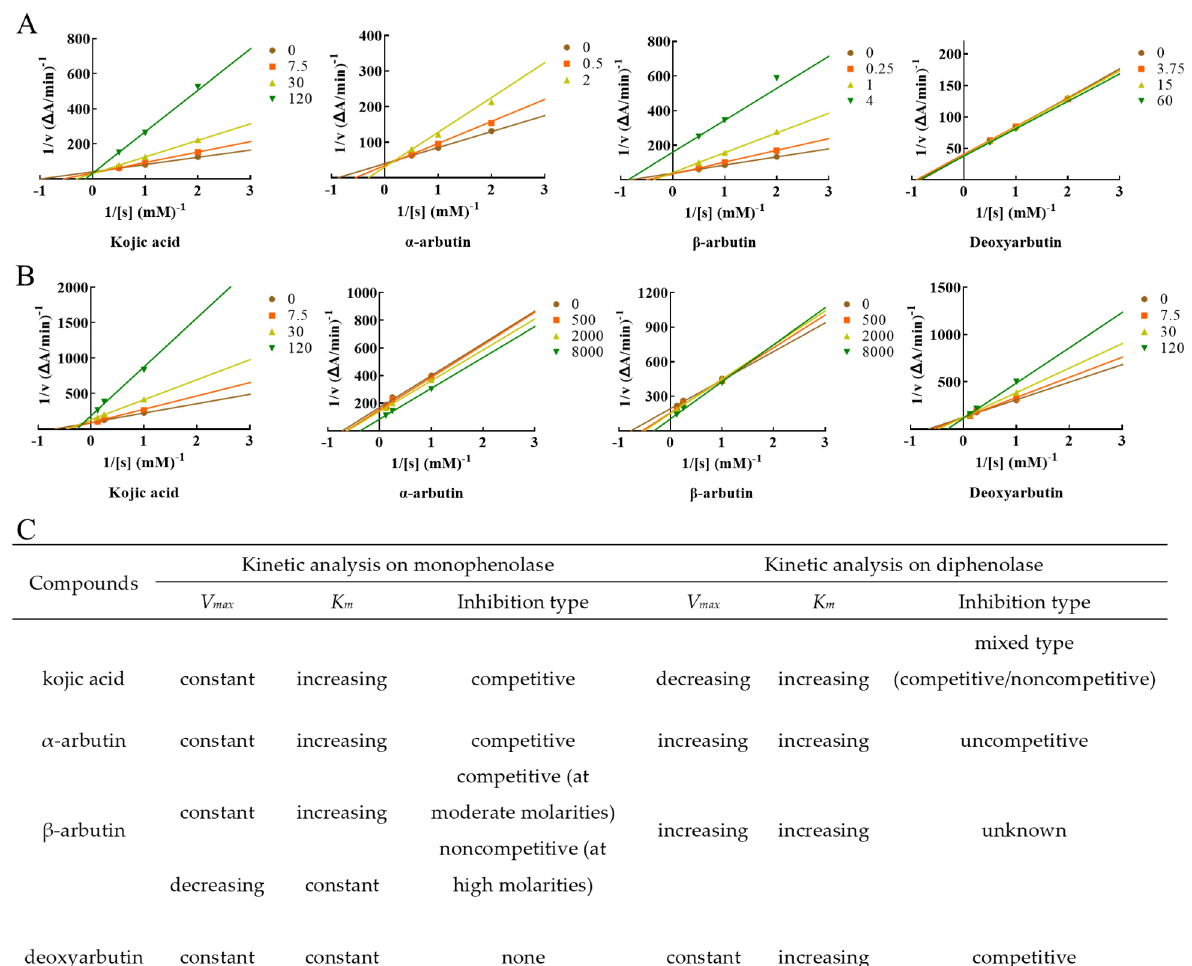
Figure 4. Determination of the inhibition type of kojic acid, α -arbutin, β -arbutin, and deoxyarbutin on monophenolase and diphenolase from MTYR. ( A ) The Lineweaver–Burk plot for kojic acid, α - arbutin, β -arbutin, and deoxyarbutin on monophenolase; ( B ) The Lineweaver–Burk plot for kojic acid, α -arbutin, β -arbutin, and deoxyarbutin on diphenolase; ( C ) Kinetic parameters and inhibition type of kojic acid, α -arbutin, β -arbutin, and deoxyarbutin on monophenolase and diphenolase. Changes of V max and K m with the increasing compound molarity were shown.